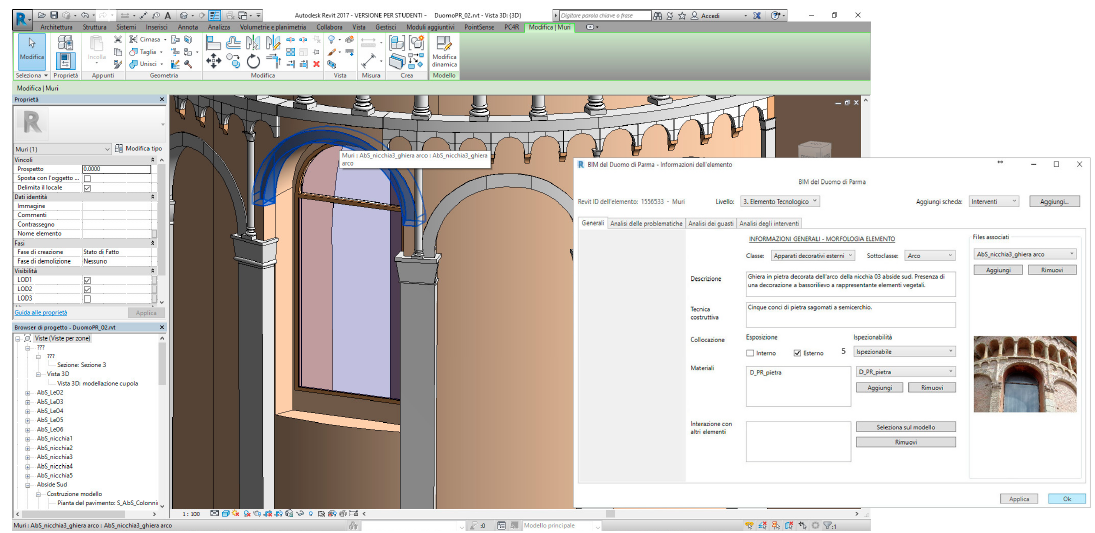
Figure 5. Example of access to data from the database within the Revit environment.